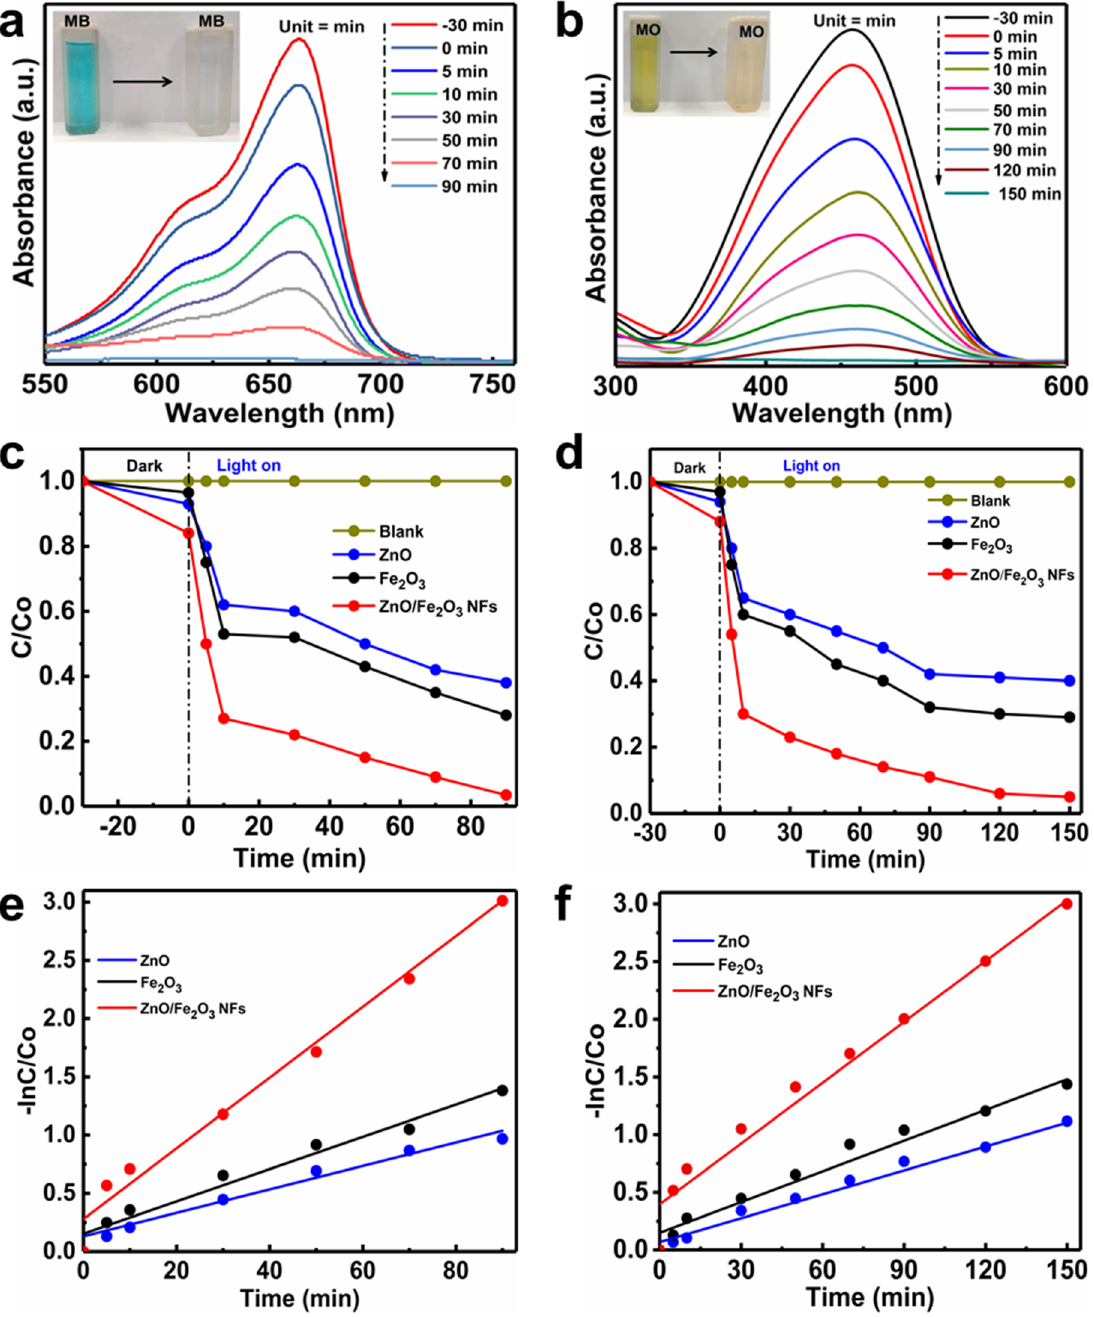
Figure 7. ( a , b ) Absorption spectra, ( c , d ) photodegradation curves, and ( e , f ) photodegradation reaction kinetic linear simulation curves under UV light irradiation for ( a , c , e ) MB and ( b , d , f ) MO with the photocatalysts of ZnO/Fe 2 O 3 NFs, ZnO and Fe 2 O 3.